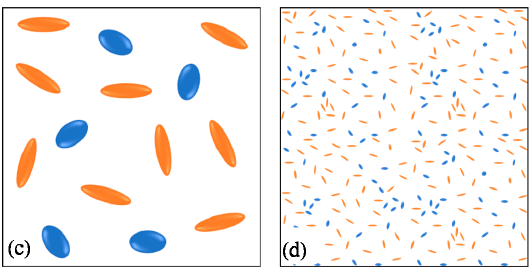
Figure 1. Inclusion geometries and orientation for: ( a ) Minnich and Chen [18]; ( b ) Ordonez-Miranda and coworkers [19]; and ( c ) generalized EMT—current work; ( d ) A schematic representation non-uniformly distributed inclusions—current work (inclusion sizes are not to